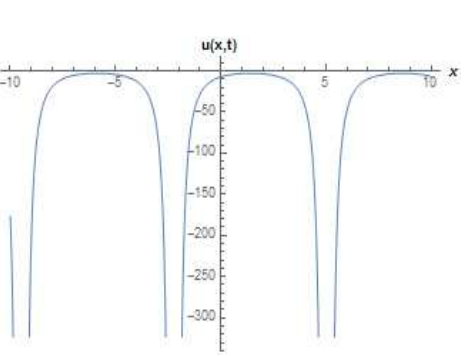
Figure 7. The 2D and 3D shape for the Eq. (20) with the values k = 2, c 0 = 1, p = 1, 0 . 5 < x < 1, − 0 < t < 2 and t = 0 . 7 for the graphic of